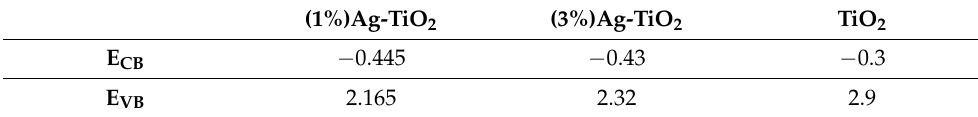
Table 4. Result of E CB and E VB of (1%)AgTiO 2 , (3%)AgTiO 2 and TiO 2